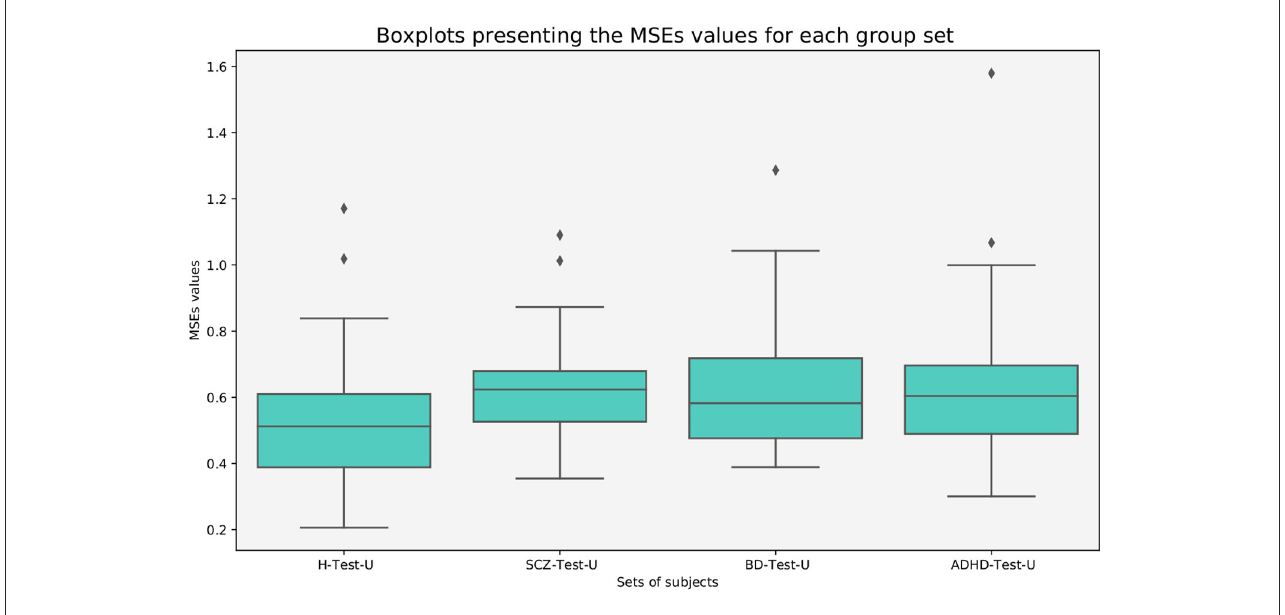
FIGURE1 Boxplots presenting the MSE s values of all subjects, for each group.